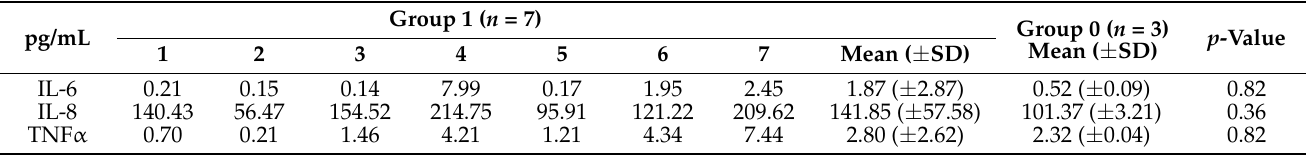
Table 1. Salivary cytokines in pg/mL of patients included in Group 1 compared to the mean values of the reference group (Group 0).